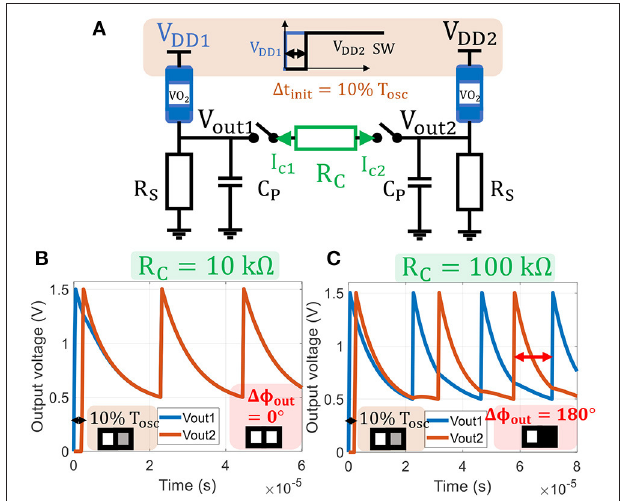
FIGURE 4 | (A) Two identical VO 2 oscillators are coupled with a resistance R C and switches. V DD 2 starting time and coupling time t on are delayed by 0.1 T osc with respect to the first oscillator, representing a light-gray second pixel as ONN input. (B) Output voltages for R C = 10 k (cid:127) : the oscillators converge to an in phase state (0 ◦ , 0 ◦ ) and the corresponding output pattern corresponds to two white pixels. (C) Output voltages for R C = 100 k (cid:127) : the oscillators are out-of-phase (0 ◦ , 180 ◦ ) and the output pattern corresponds to a white and a black pixels.